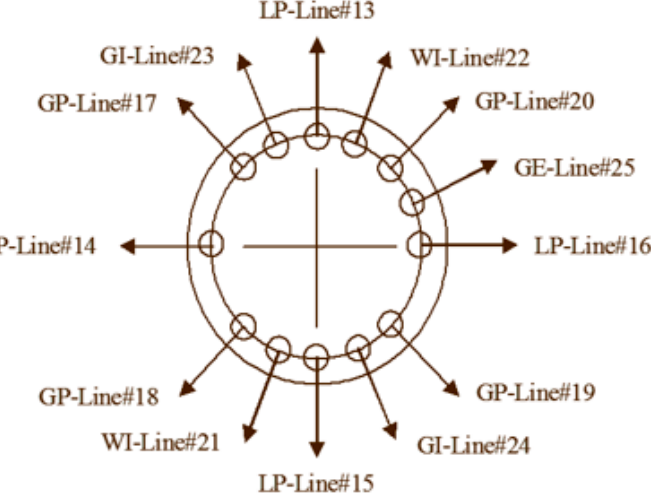
Table 6 . Riser Particulars.